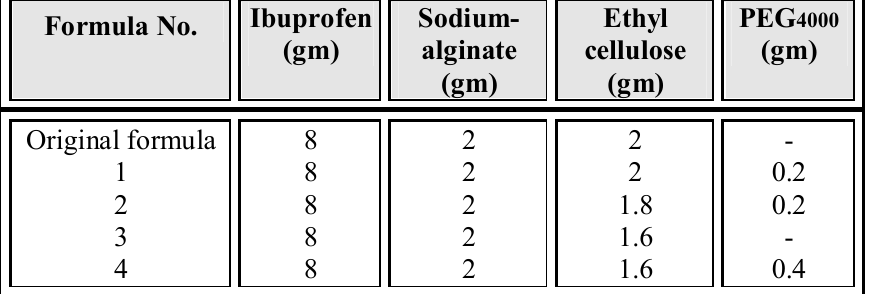
a Modified Organic